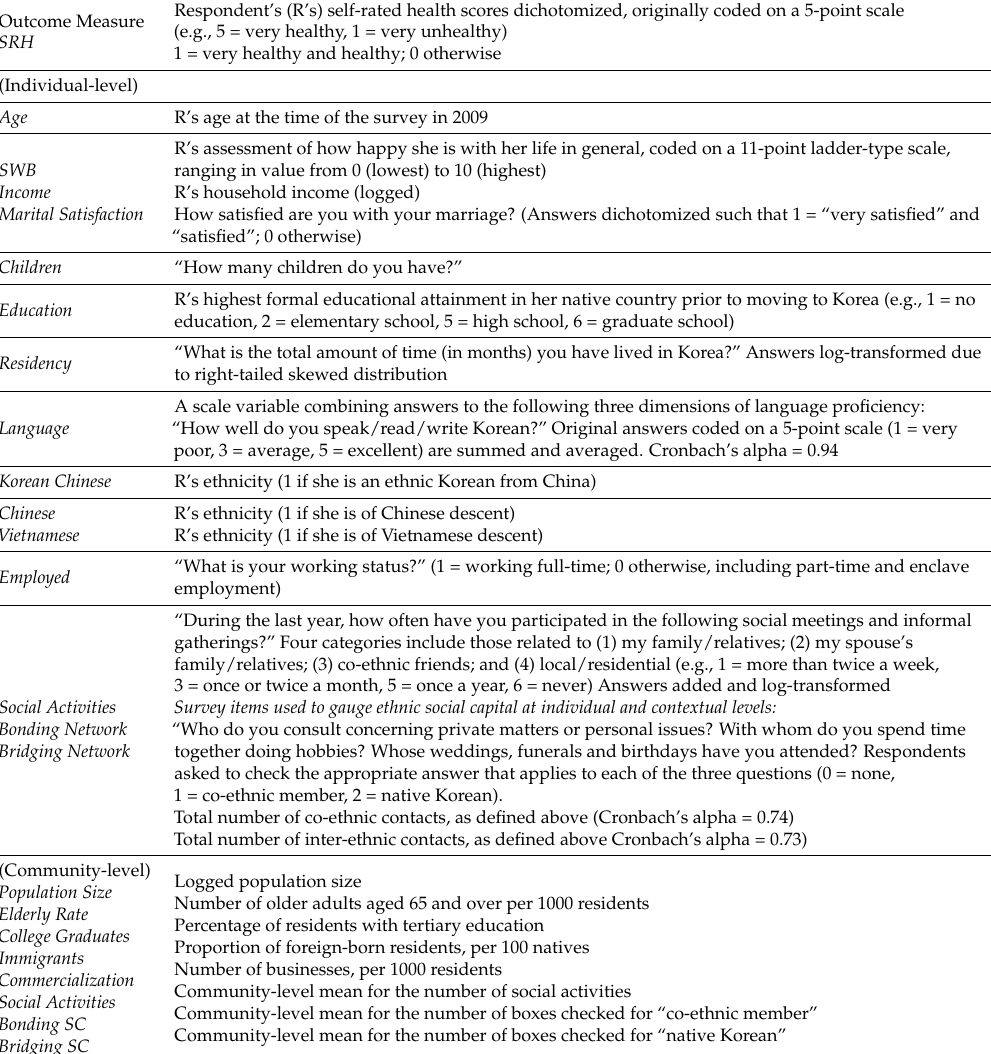
Table 1. Summary of variable definition and coding